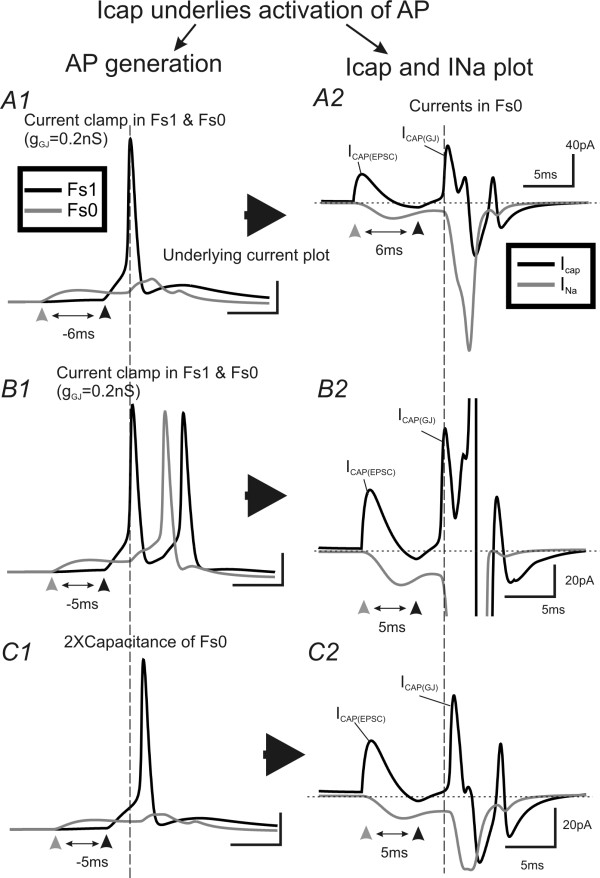
Mechanisms of interaction of transient EPJP and EPSPs: Icap. In all panels, FS0 and FS1 are coupled by GJs (gGJ = 0.2 nS). A1) A weak, subthreshold TC input in FS0 (gray trace) precedes (6 ms) a strong, suprathreshold TC inputs to FS1 (black trace). A2) INa (gray) and Icap (black) in soma of FS 0. B1) The weak TC input arriving at FS0 precedes the suprathreshod TC inputs by 5 ms. Note that the same TC input now induced suprathreshold responses in FS0. B2) INa(gray) and Icap (black) in soma of FS 0. Note that the peak of Icap precedes the large inward INa. C) Experimental conditions in C are exactly the same with B, except that the capacitance of the FS0 was doubled. Now the same TC response failed to induce action potential in cell FS0. Note that the Icap in C2 was relatively smaller than B2.